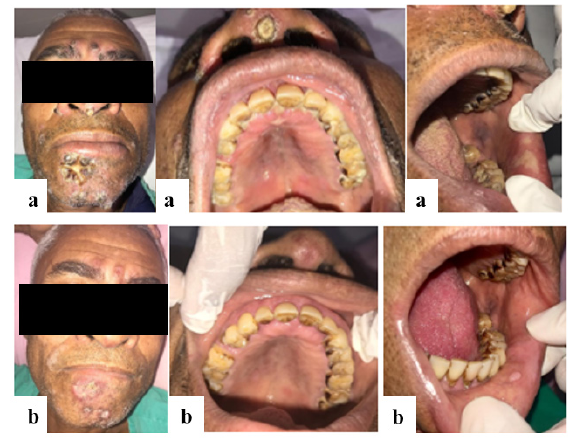
Figure 4. Ulcerated lesions in face, marginal gingiva, palate, and labial mucosa, before ( a ) and after treatment with liposomal amphotericin B ( b ) reported at Case-7.